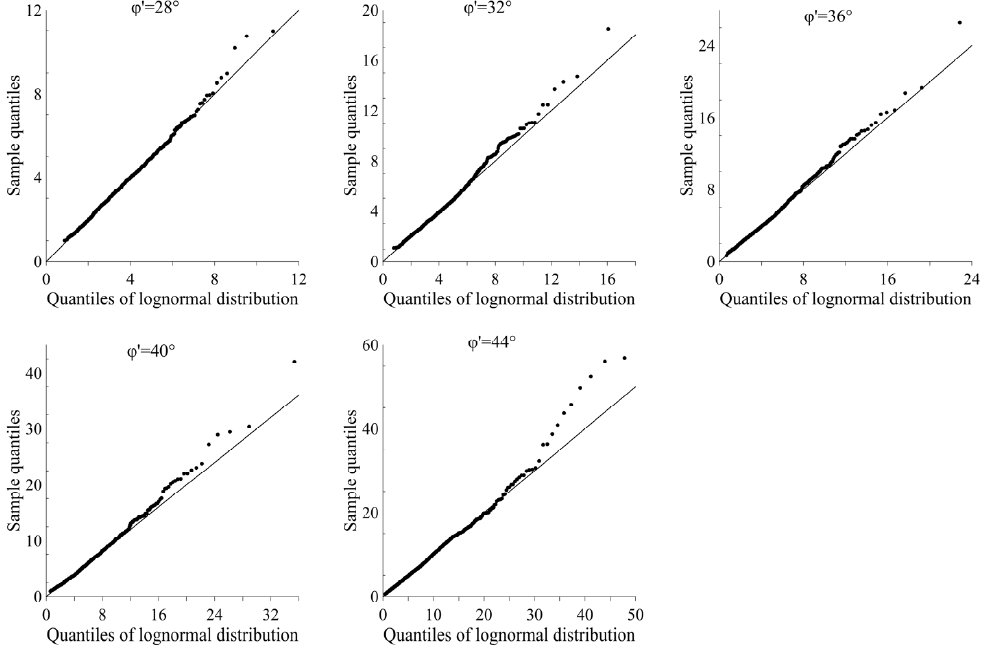
Figure 7. Q-Q plots of lognormal distribution. Table 6. Quantiles to which the lognormal Q-Q plots are